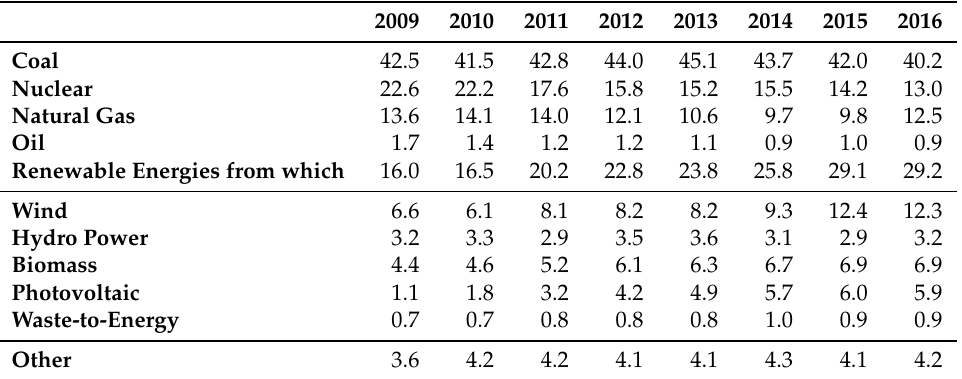
Table 1. Electricity production in Germany by source (%), see [12].